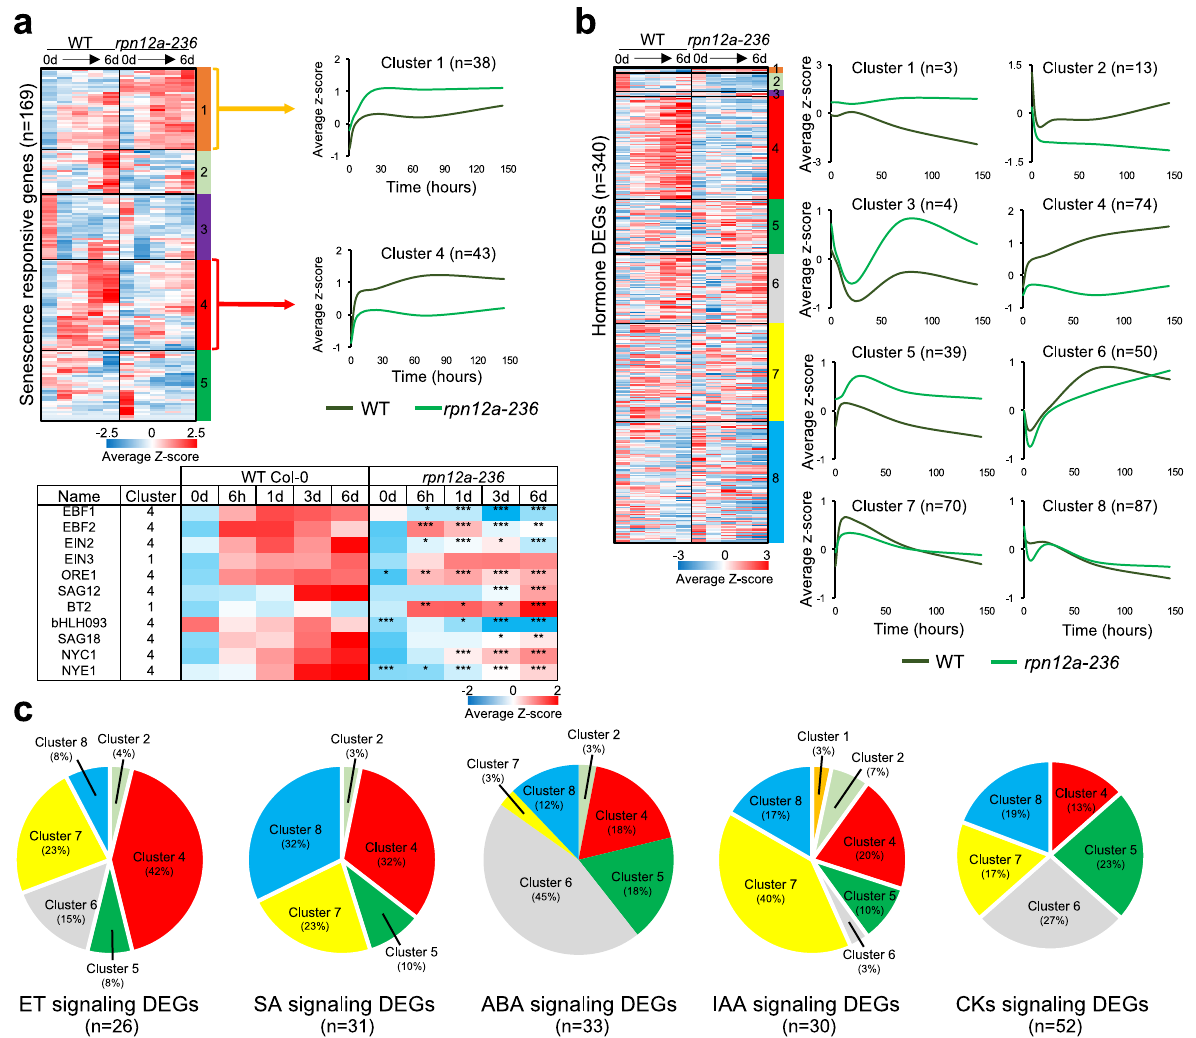
Fig. 5 Senescence- and hormones metabolism-associated genes expression analysis. a Analysis of senescence-associated genes. Top left: the heatmap was divided in 5 clusters de fi ned by hierarchical clustering using MeV (Pearson correlation). Top right: the graphs depict the overall abundance pattern of transcripts for WT and rpn12a-236 in the two selected clusters. Average Z -score was plotted overtime for each cluster. Bottom: expression pro fi le of key genes involved in senescence and found in clusters 1 and 4. A Student ’ s t -test (two sided) showed statistically signi fi cant differences at * p < 0.01, ** p < 0.001, *** p < 0.0001. b Hierarchical clustering of DEGs associated with hormone biosynthesis, conjugation and signaling. Of the 646 genes of the list (see Supplementary Data 5), 340 are differentially expressed for one or more time point in rpn12a-236 at p < 0.0001. After hierarchical clustering, the dataset was divided in to 8 clusters, which are presented on the right. Average Z -score was plotted overtime for each cluster. c Pie charts illustrating the distribution of genes involved in hormone signaling among the clusters generated in b . ABA: abscisic acid, CKs: cytokinins, ET: ethylene, IAA: auxin, SA: salicylic